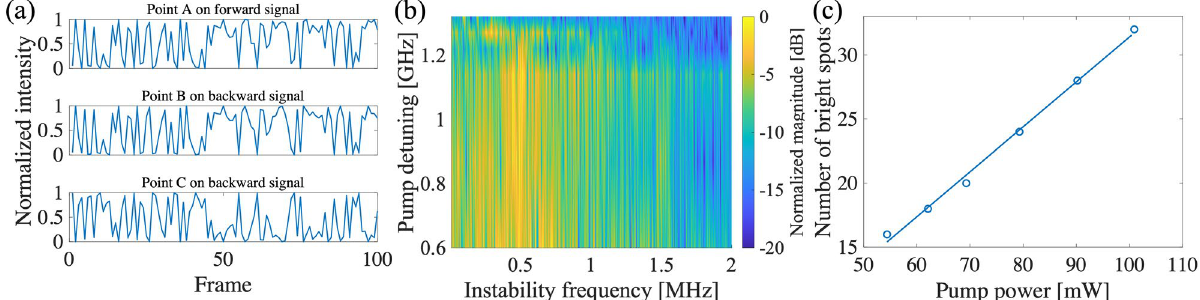
Figure 3. ( a ) Raw frame-by-frame intensity fluctuation of three camera pixels (A, B, and C pixels) in forward and backward directions. Pixels A and B show intensity correlation while pixel C shows anti-correlation. ( b ) Frequency spectrum of a single camera pixel for different pump detuning shows dynamic instability of scattering intensity. ( c ) Spatial frequency of the scattering ring obtained by counting the number of bright spots around the ring plotted as a function of pump power that shows linear dependency, in agreement with the theory (see of the counter-propagating pump fields (due to polarization self-rotation) induces an angular momentum on the standing wave 23,24 . This angular momentum is transferred to the scattered light resulting in an interference pattern along the ring. We observe a linear dependency of the spatial frequency on the pump power (see Fig. 3c), which is in agreement with the theory of polarization rotation where the ac-Stark shift changes linearly with the optical power. The refractive index modulation, due to the standing-wave pump, coherently splits the scattering light propa- gating in opposite directions (i.e. the Bragg effect). Along with co- and counter-propagating four-wave mixing directions, this gives rise to the observation of two-mode and four-mode correlations in our system. Below, we first calculate the normalized intensity-difference noise of the AMWM signal for multiple spatial modes and compare it with the intensity-sum noise of the same two modes. We evaluated the noise in the intensity difference between different regions of the counter-propagating rings. We calculated the intensity-difference noise (or variance) normalized by intensity-sum noise, as a function of the relative angles between the rings. Figure 4 summarizes the results of the relative noise measurements between the AMWM signal, as a function of relative orientations. We defined the reference angles for each ring, θ 1 and θ 2 , and digitally rotated one ring before subtracting the normalized intensities, to obtain the intensity-difference noise between the angular segments of the counter-propagating rings. This is achieved by first centering the two rings, and flipping one ring around its symmetry axis to align the correlated pixels of the two rings. By taking variance of the subtracted normalized intensity over time-sequenced images, we calculate the noise and normalize it to the variance of the intensity sum. To avoid influence of uneven intensity distribution over the rings, intensity of each pixel is normalized to temporal mean of that pixel. We can calculate the noise due to the total ring intensity, a segment of the ring, or a single pixel. We note that in this process we discard the saturated pixels. The angular intensity correlation between counter-propagating rings is plotted in Fig. 4a for the relative noise in segments (or the entire area) of the rings. Each segment of the forward-propagating ring at an angle θ 1 shows correlations with multiple segments of the counter-propagating rings centered at the θ 2 angle. These correlated multiple segments match the periodic patterns of the rings. Figure 4b shows the relative intensity noise as a function of the analyzed angular segment size. As also shown in Fig. 4a, smaller segments have more noise reduction than larger segments in both detunings. A noise reduction close to 20 dB is observed at the pump detuning of 1.5 GHz and using a small analyzing segment size. Figure 4c,d show again the relative intensity noise for all segments (with different angular positions) of the forward- and backward-propagating rings at pump detunings of 0.9 GHz and 1.5 GHz, respectively. The seg- ment size is chosen to be as small as a single pixel size. δθ 1,2 is the angular displacement from the segment with